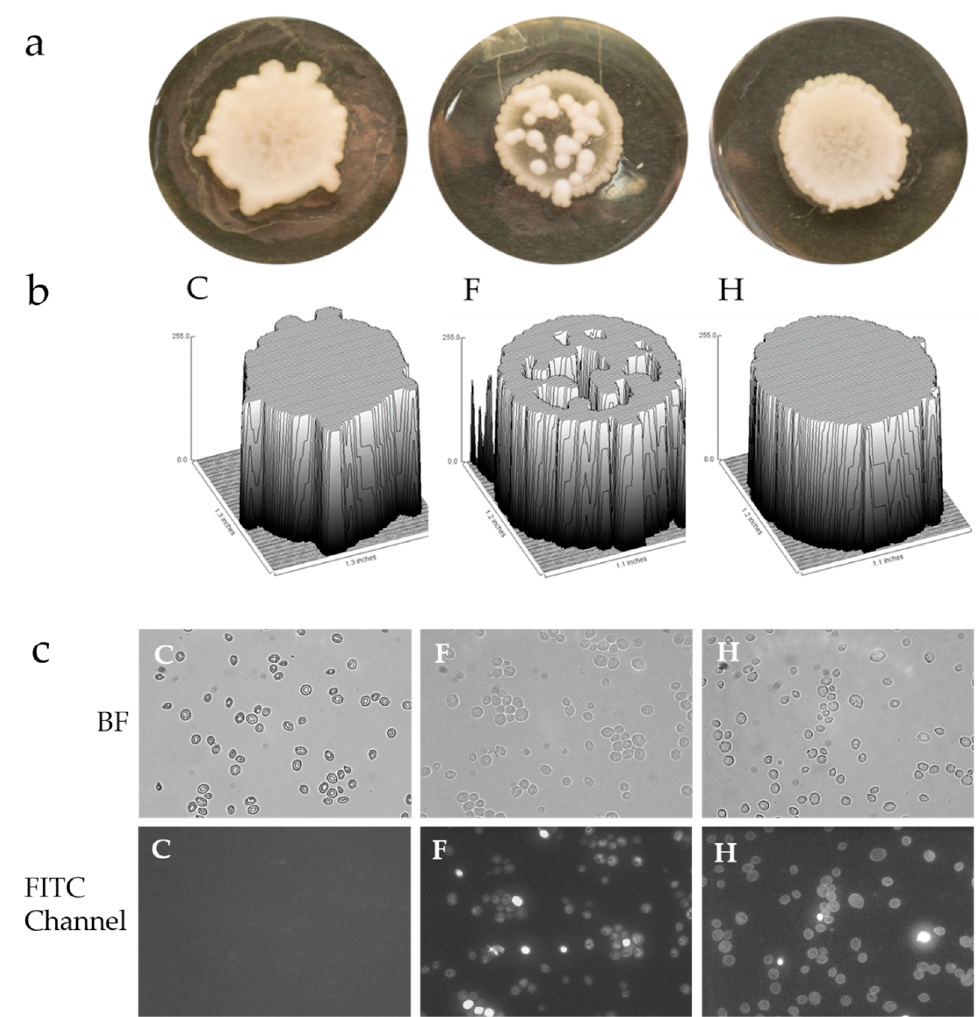
Figure 7. Photosensitizer effect on colony growth. Colonies of S. cerevisiae grown on solid-medium change morphology after exposure to either fagopyrin or hypericin. ( a ) Yeast cells were grown for 15 days in YPD plates without photosensitizers (C) and in media containing either 100 µM fagopyrin (F) or 100 µM hypericin (H). ( b ) Surface plots of the colony intensities of pixels in a grayscale using ImageJ. ( c ) Microscopic images of cells from the colonies in the bright field (BF) and with FITC channel (488 nm laser excitation) showing different fluorescence patterns for fagopyrin and hypericin. Arrowheads (white) show cells with aberrant morphologies. Scale bar, 15 µm.